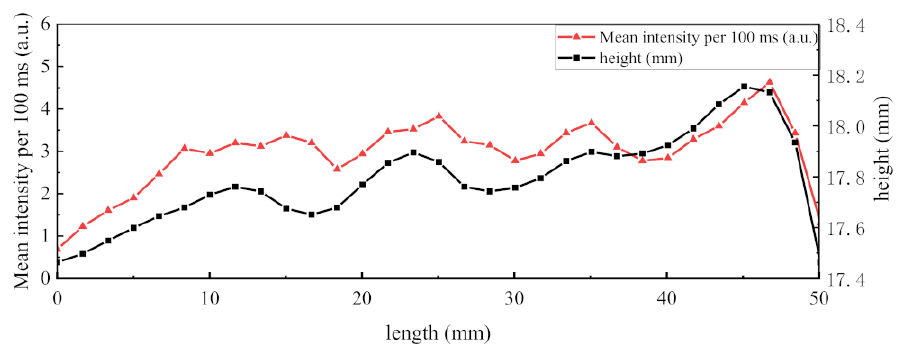
Figure 13. Relationship between mean intensity of the reflected laser and the height profile of the top